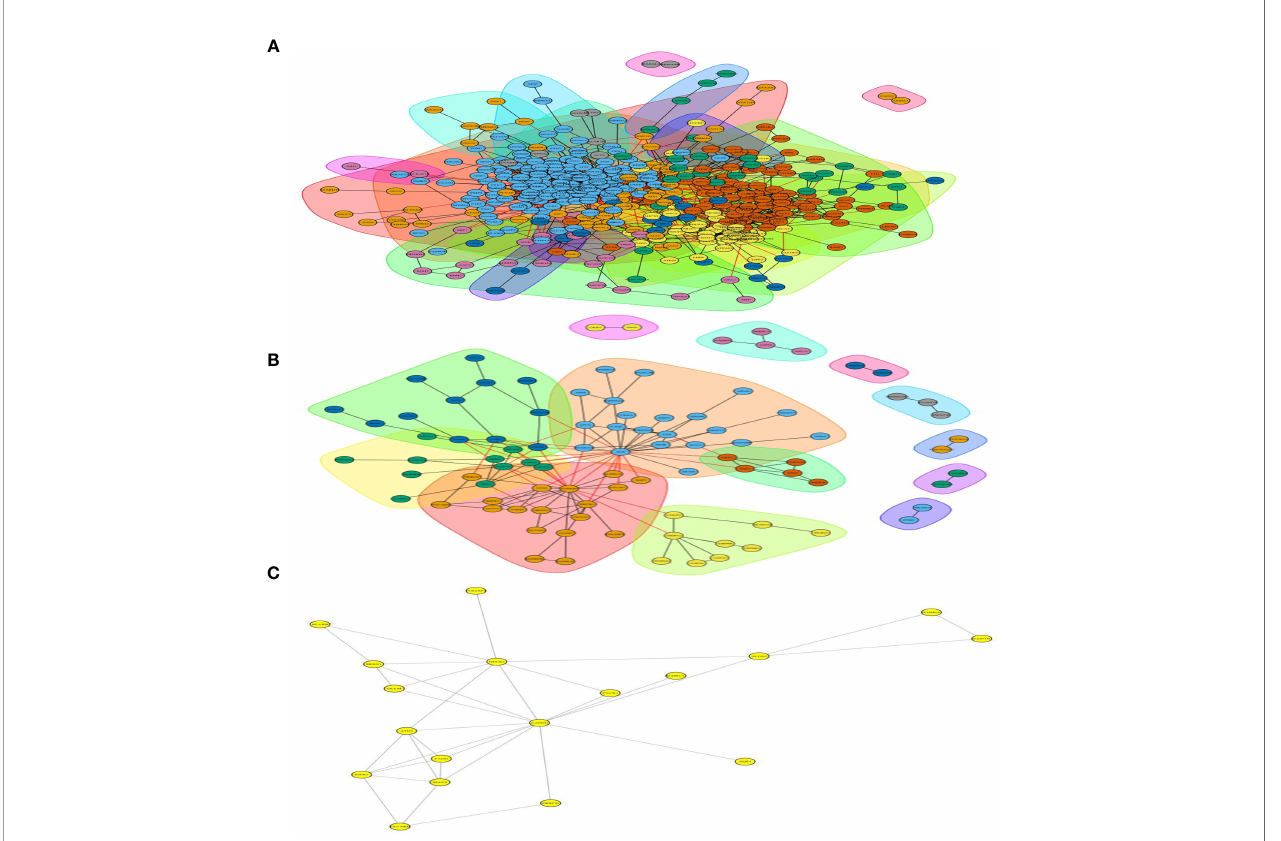
FIGURE 5 | Differentially expressed protein interaction networks in group of Ca_vs_CaP and Cs_vs_Cr. In the protein interaction network, nodes represent proteins and lines represent protein – protein interactions. Yellow nodes are differentially expressed proteins. The number of proteins directly interacting with protein A is called the linkage degree of the protein. (A) Differentially expressed protein interaction networks in group of Ca_vs_CaP. (B) Differentially expressed protein interaction networks in group of Cs_vs_Cr. (C) FADD and RIPK1 involved interacting